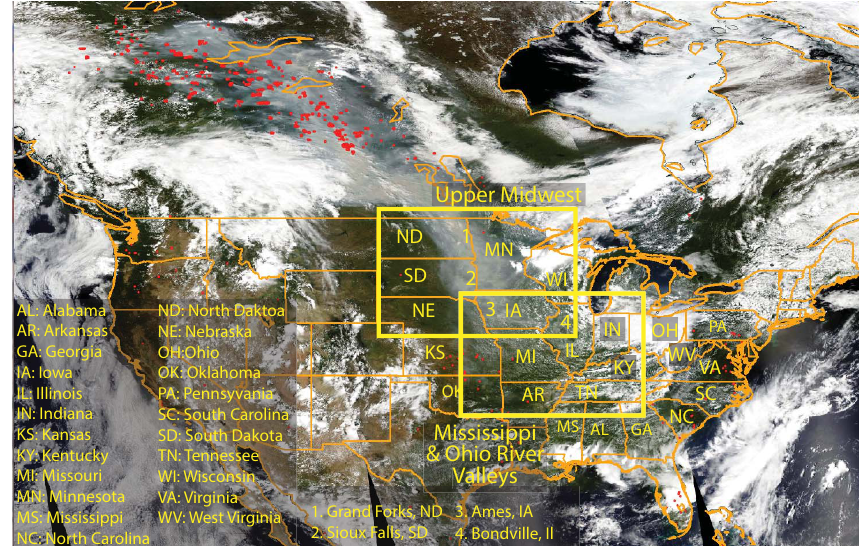
Figure 1. Overview of the study region based on the RGB Aqua MODIS overpass of 29 June 2015 with marking of study domains (yellow boxes) and states referred to in the text. Terra and Aqua fire hotspot detections for that day are also marked in red.